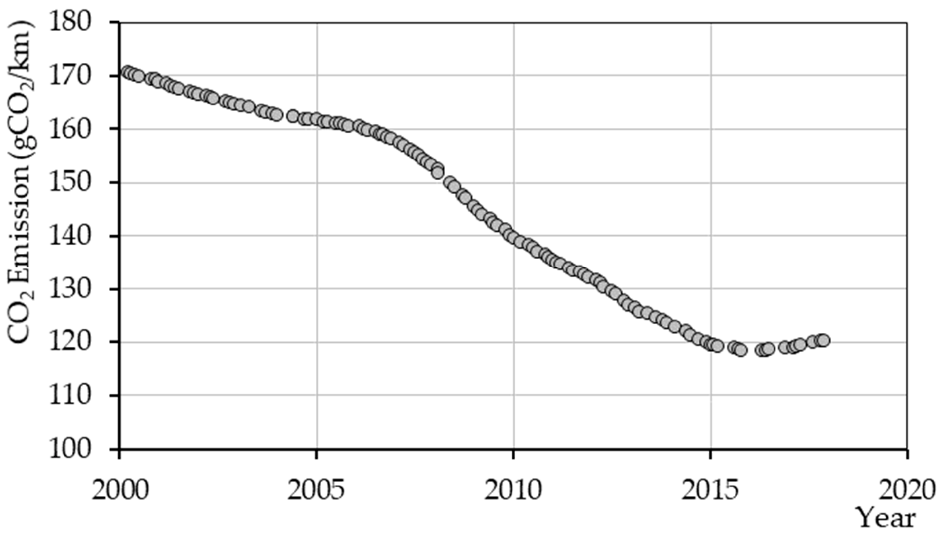
Figure 1. The average carbon footprint of a newly registered car in the EU.